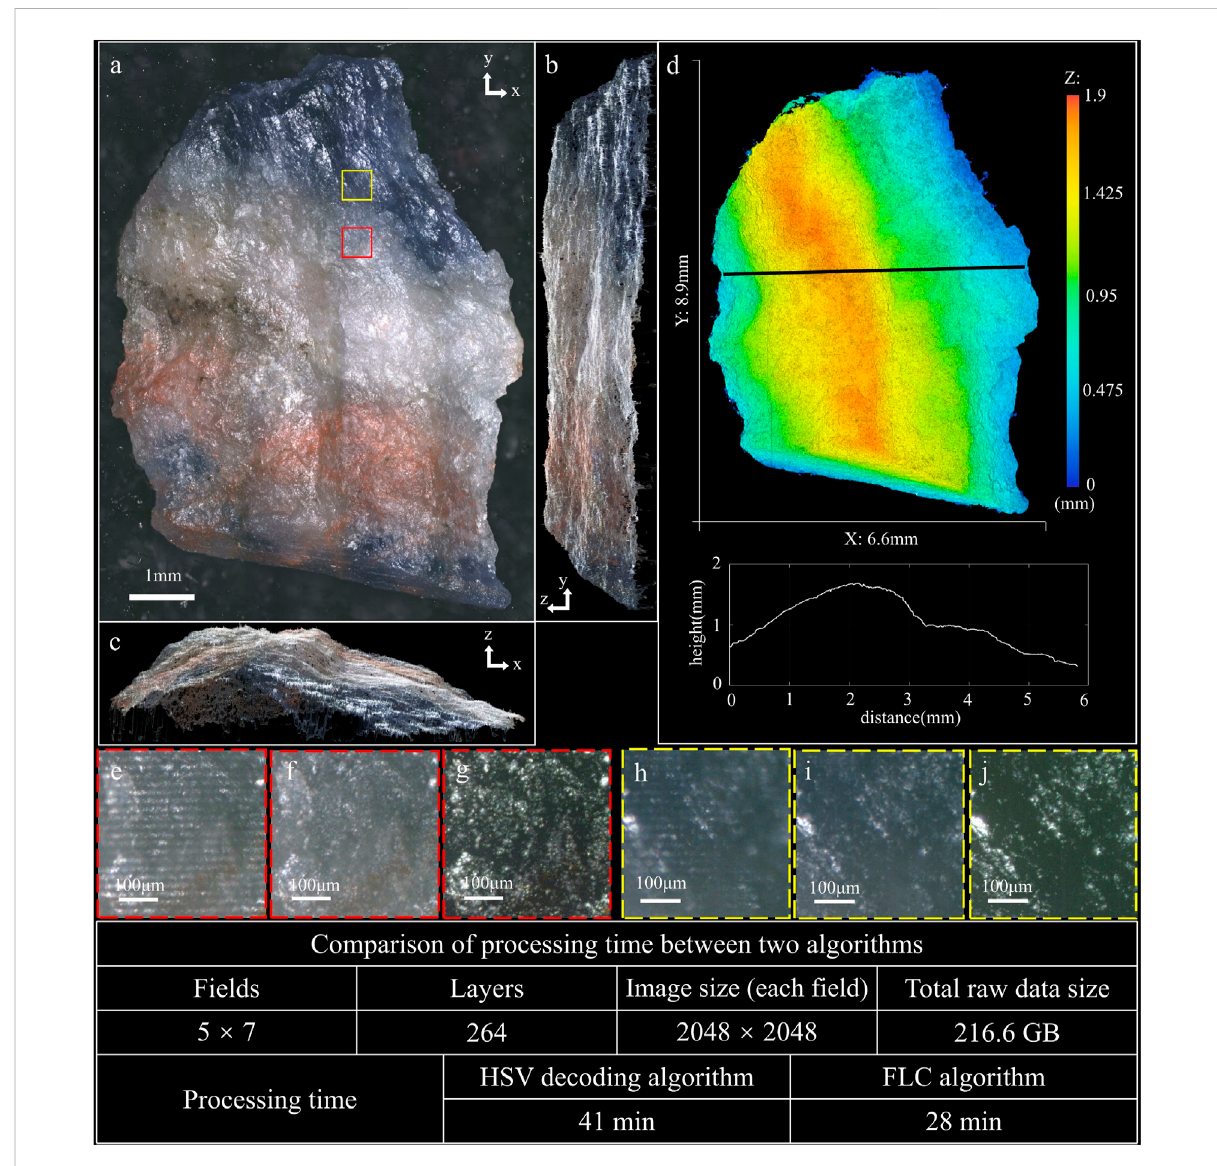
FIGURE 4 3Dimagingresultofblue-veinsstone(seeSupplementaryVideoS2). (A) MIPimagealong z axis. (B) MIPimagealong x axis. (C) MIPimagealong y axis. (D) Height map of the sample, with the pro fi le along the black line-scan. (E) Raw image of the white area with focused modulated fringe. (F) Image restored by the FLC algorithm corresponding to the region of (E) . (G) Image restored by the HSV decoding algorithm corresponding to the region of (E) . (H) Raw image of the blue area with focused modulated fringe. (I) Image restored by the FLC algorithm corresponding to the region of (H) . (J) Image restored by the HSV decoding algorithm corresponding to the region of (H)